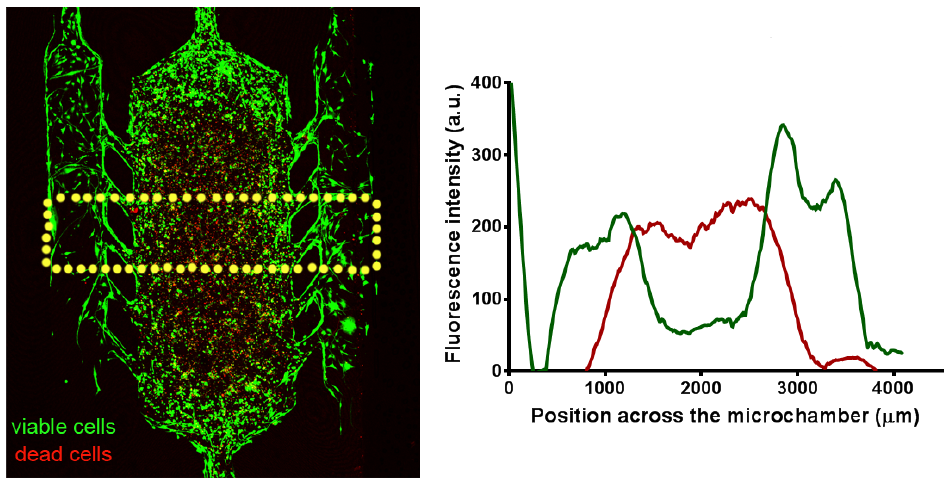
Figure 1. Formation of a necrotic core in the microfluidic